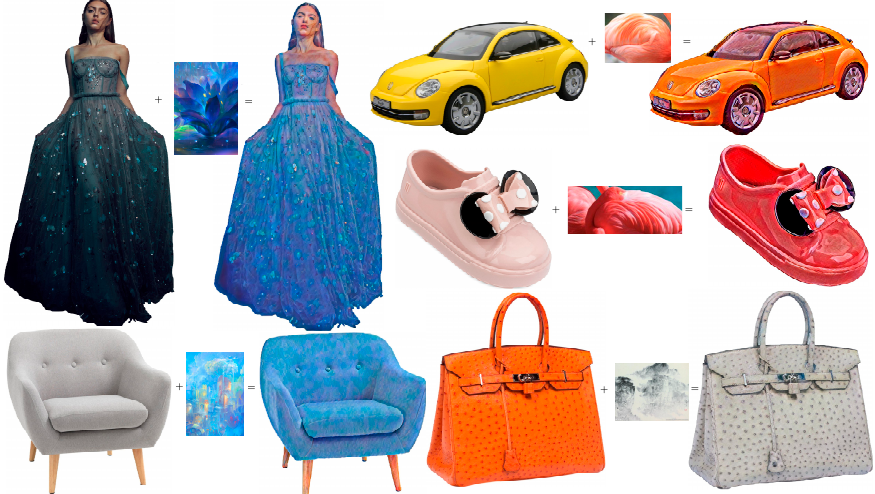
Figure 7. Product designs based on neural style transfer. ( a ) The content images. ( b ) The style images. ( c ) The results. We inputted ( a , b ) into the style transfer model, after simple processing, such as